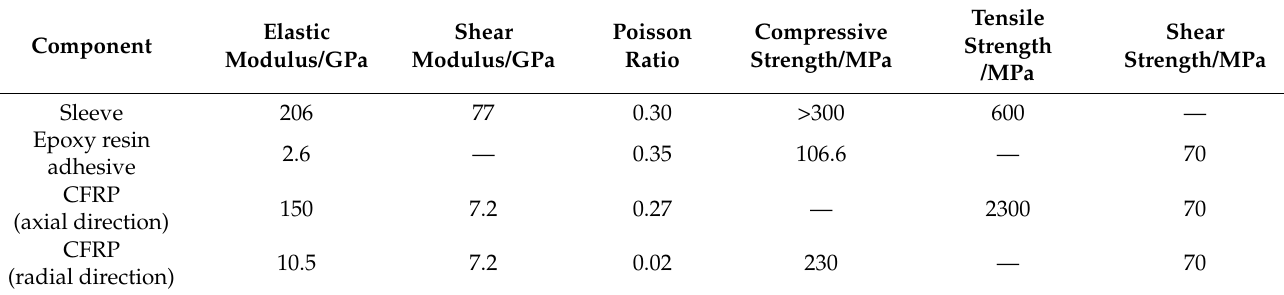
Table 1. Material performance parameters of anchoring